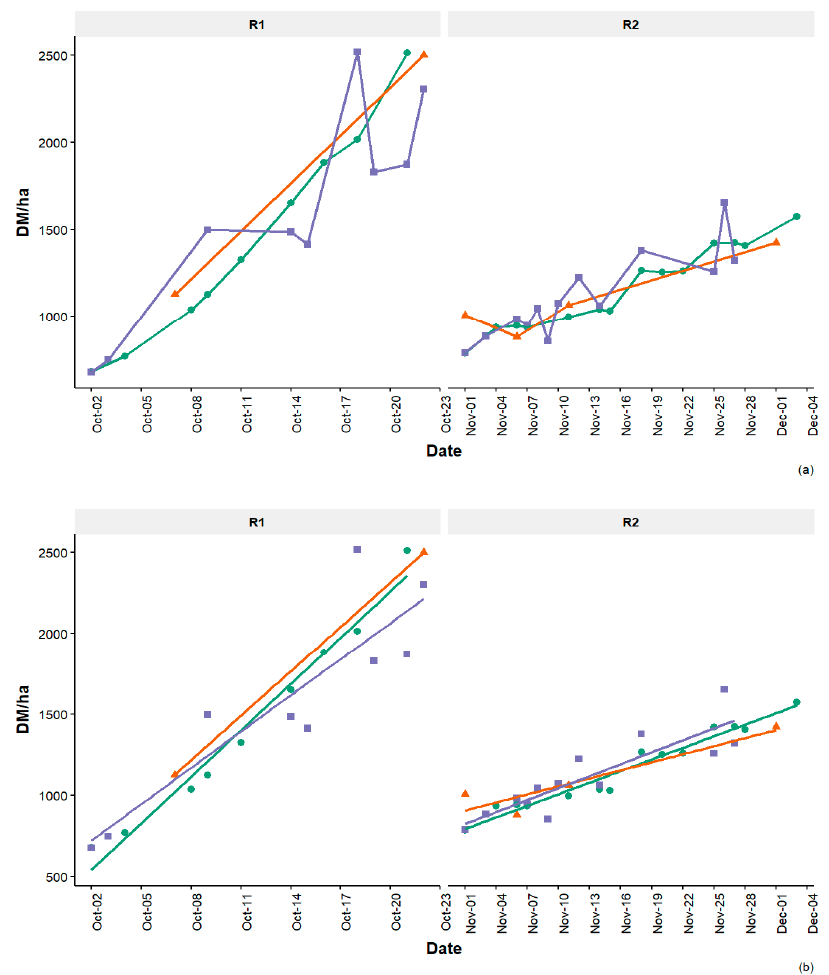
Figure 6. ( a ) Average pasture biomass (kg DM / ha) per regrowth period (R1 and R2) for the electronic rising plate meter ( • ,—), Planet satellite ( (cid:4) ;—), and Sentinel-2 satellite ( (cid:78) ;—). Each data point shows the average of the two paddocks evaluated in the experiment. ( b ) Linear regressions per regrowth period for each sensor, the slopes of the lines indicate the daily pasture growth rate (kg DM /